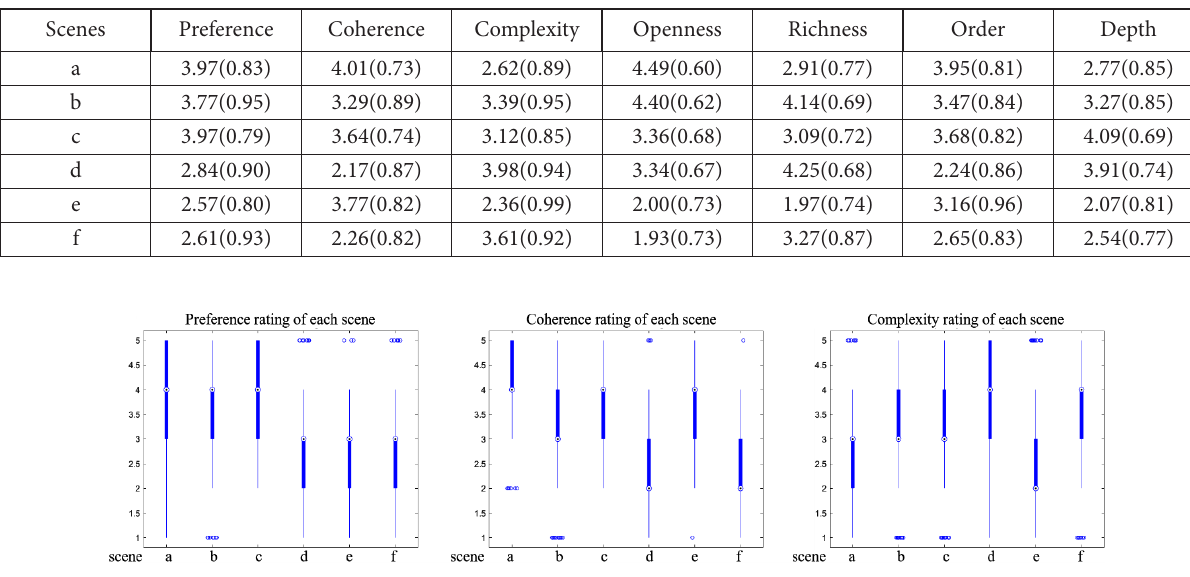
Figure 4. The box-plots for the ratings of the preference, coherence